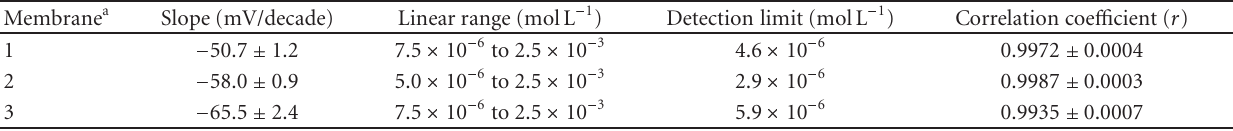
Table 1: Response characteristics of the anionic surfactant-selective electrode based on PVC membrane to SDS with di ff erent composition. Membrane a Slope (mV/decade) Linear range (molL (cid:2) 1 ) Detection limit (molL (cid:2) 1 ) Correlation coe ffi cient ( r )